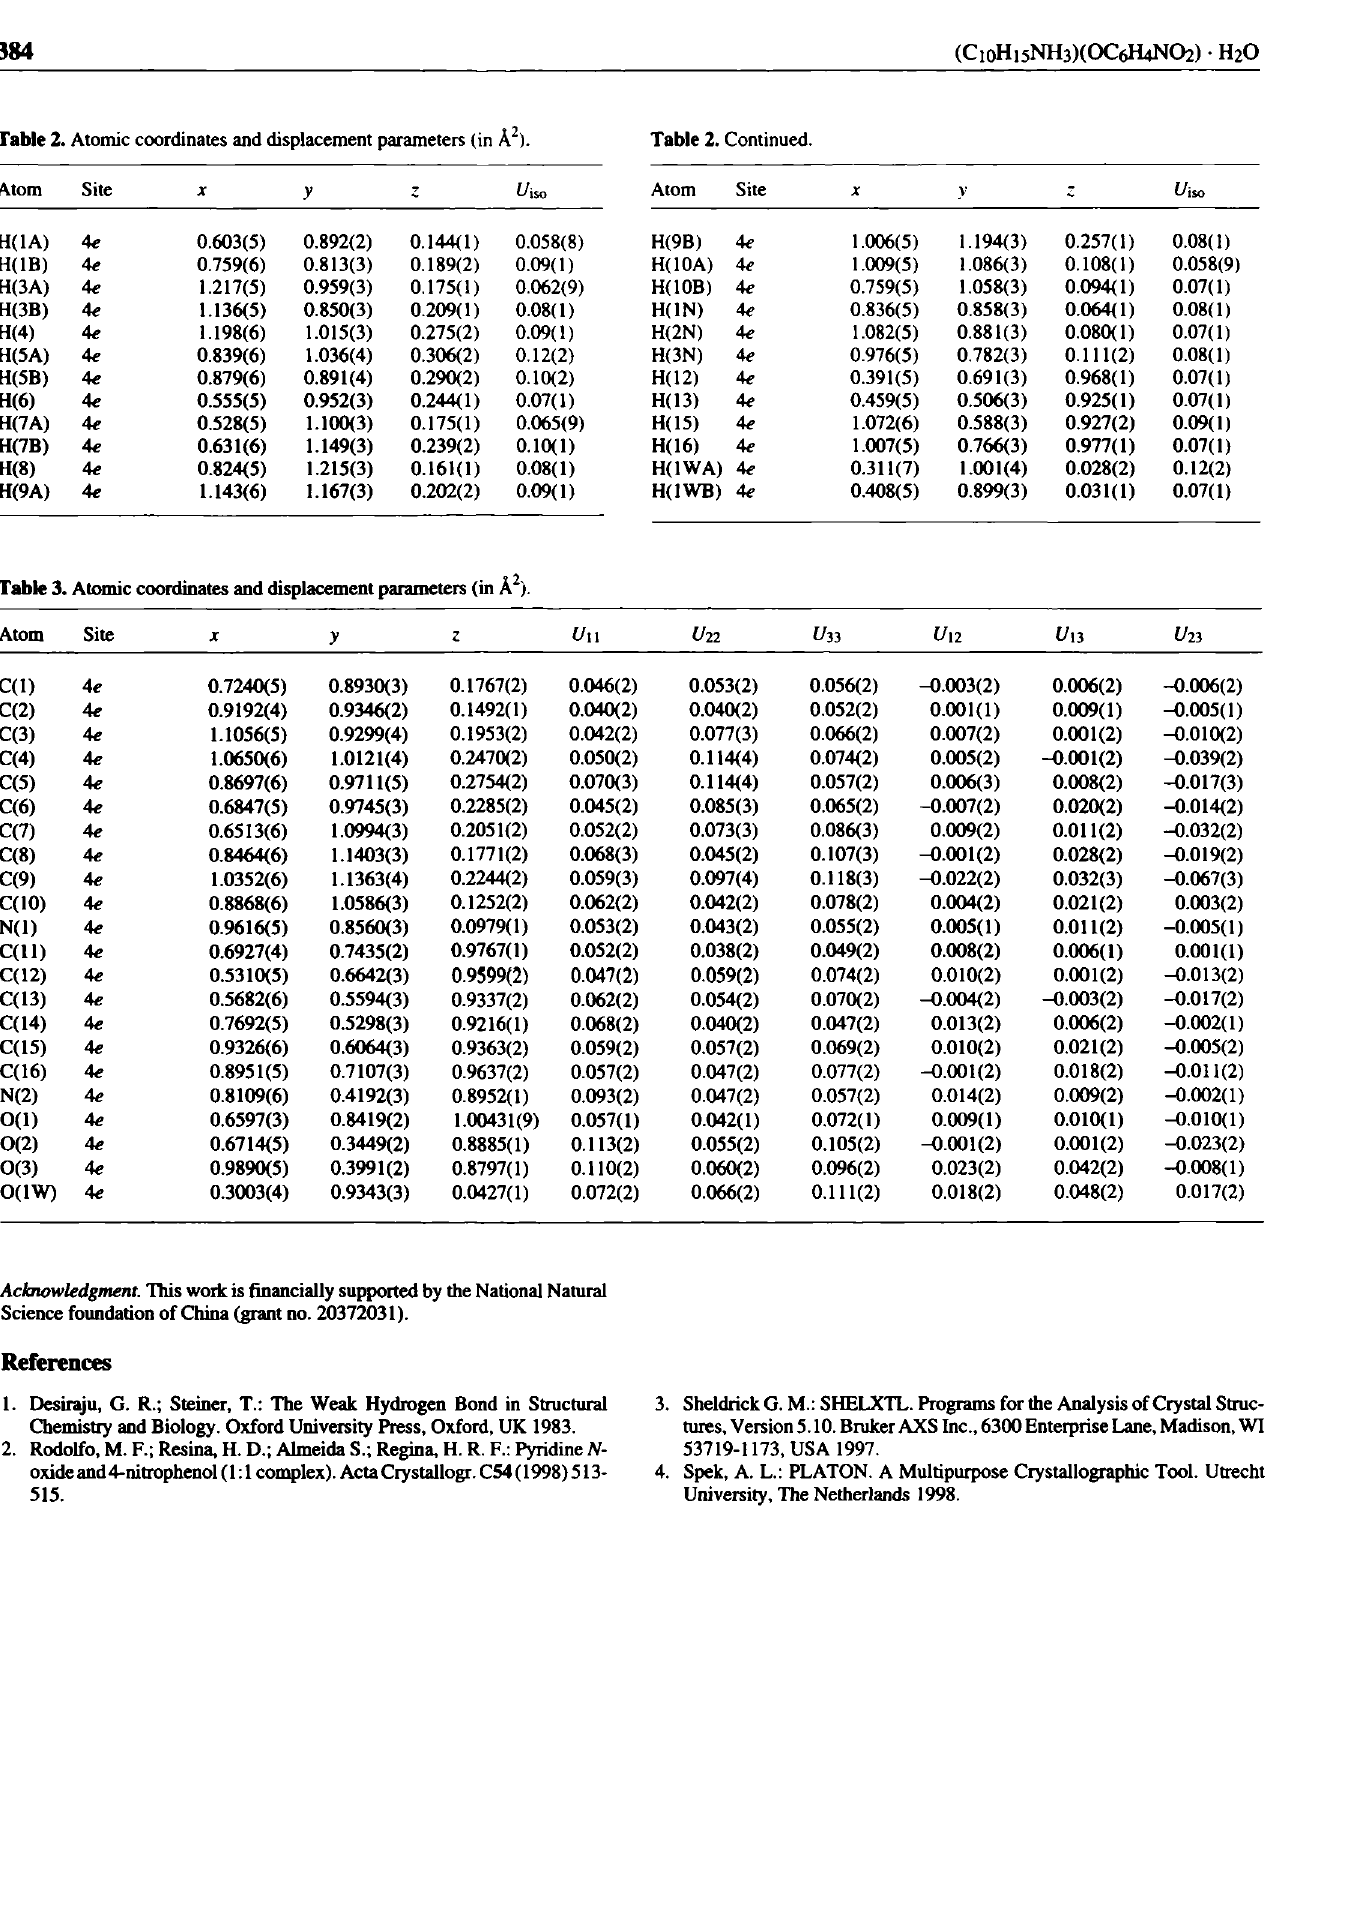
Table 2. Atomic coordinates and displacement parameters (in A 2 ).